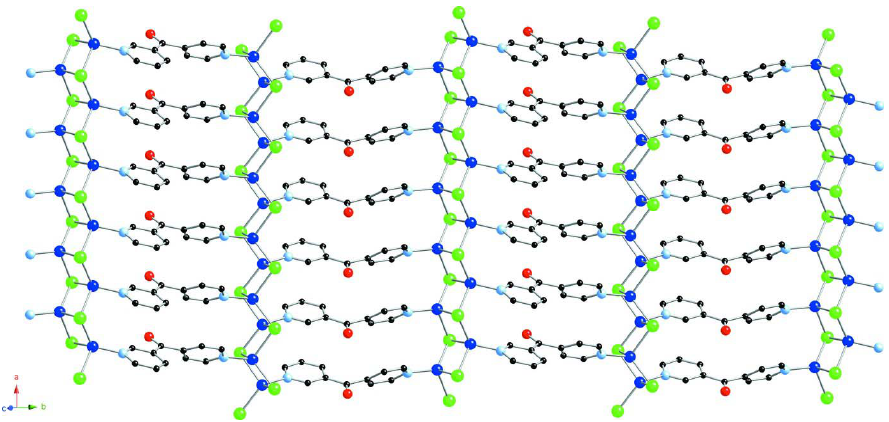
Figure 2 A single [Cu